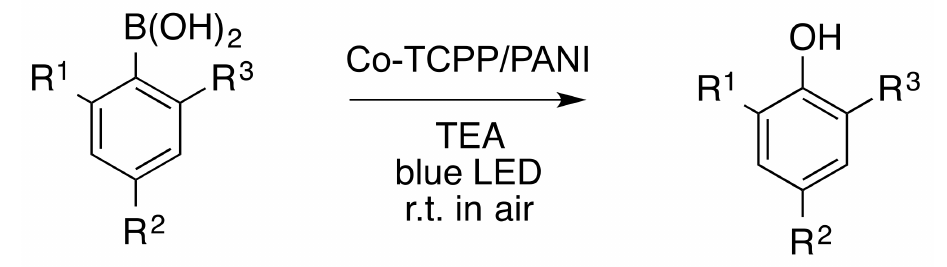
Figure 2. Hydroxylation of substituted arylboronic acids catalyzed by Co(II)TCPP /